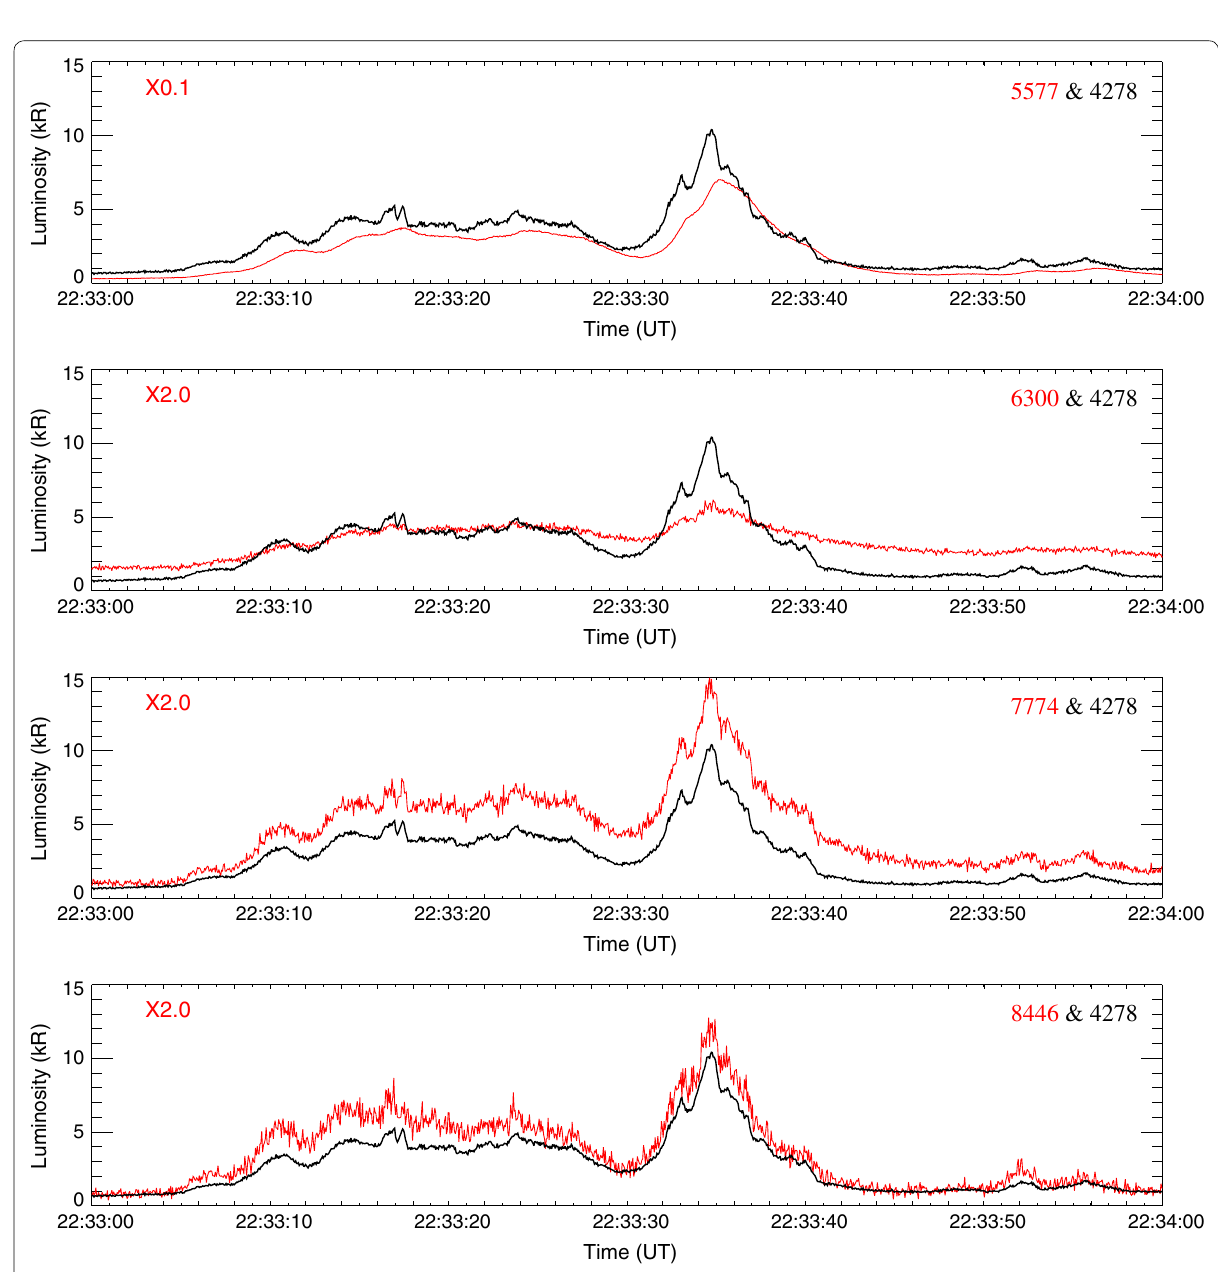
Fig. 17 Comparisons of temporal variations of auroral emissions (20 Hz data used) between 427.8 nm (black) and 557.7 nm, 630 nm, 777.4 nm, 844.6 nm from top to bottom are presented for 1 min between 22:33:00 UT and 22:34:00 UT on January 22, 2018. The emission intensities of 557. 7 nm, 630 nm, 777.4 nm, and 844.6 nm are multiplied by 0.1, 2, 2, and 2, respectively, and denoted in red solid